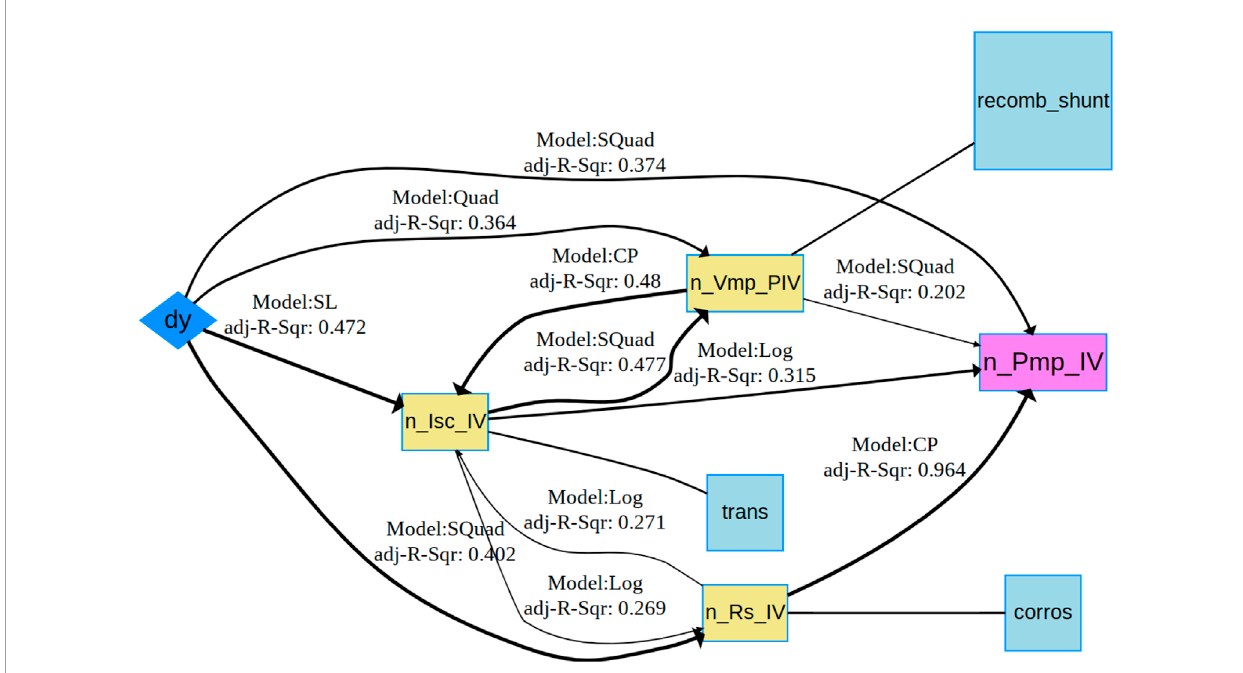
FIGURE 4 < S | M | R > model constructed using Markovian model for the variant GB with EVA encapsulation made by manufacturer B and exposed in mDH condition. dy is exposure time (stressor), n P mp , IV is maximum power, which is the response. n I sc , IV indicates short-circuit current, n R s , IV indicates series resistance and n V mp , PIV indicates voltage at maximum power (IV means that the measurement is from current-voltage data whereas PIV means it is a Suns - V oc measurement). The blue boxes indicate the degradation mode that the variable tracks: n I sc , IV tracks optical transmission loss, n R s , IV monitors corrosion and n V mp , PIV tracks recombination and shunting.